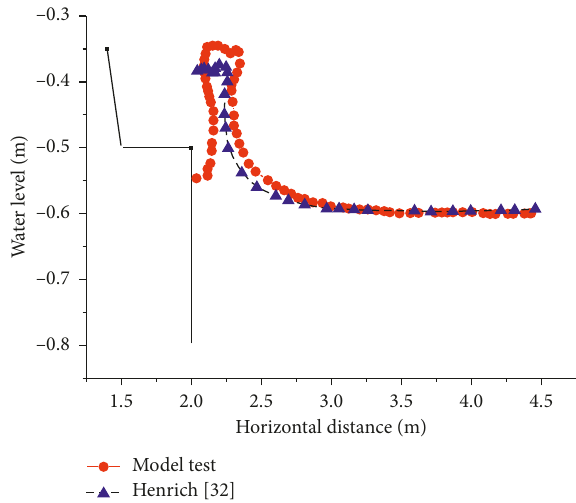
Figure 9: Trajectory in the zig-zag maneuver test recorded by